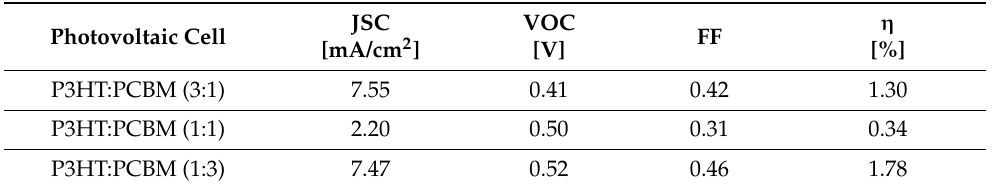
Table 4. Principal OSCs figures of merit: JSC—Current Density, VOC—Open circuit Voltage, FF—fill factor, η —power